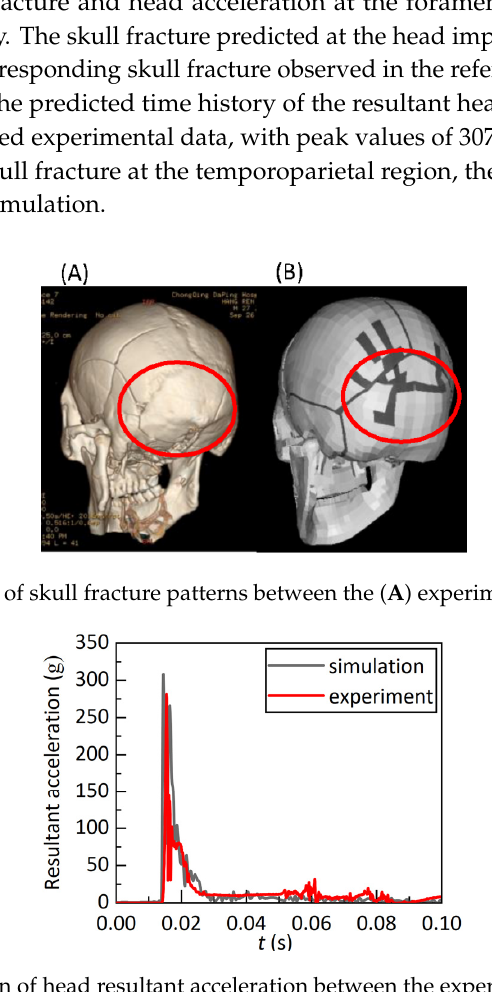
Figure 5. Comparison of skull fracture patterns Figure 6. Comparison of head resultant acceleration between the experiment and Figure 6. Comparison of head resultant acceleration between the ( A ) experiment and ( B ) simulation. between the experiment and simulation.